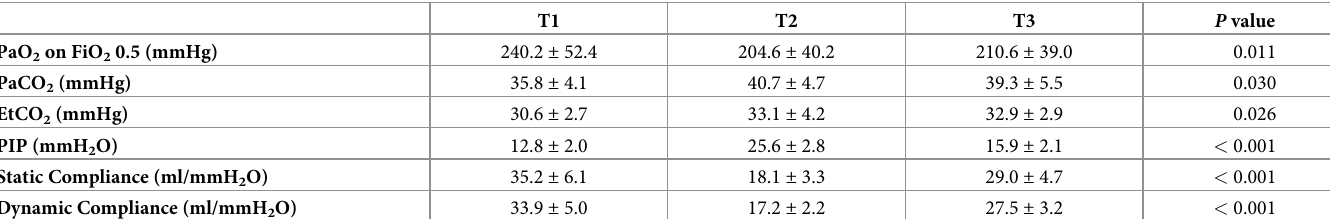
Table 2. Pulmonary variables during the